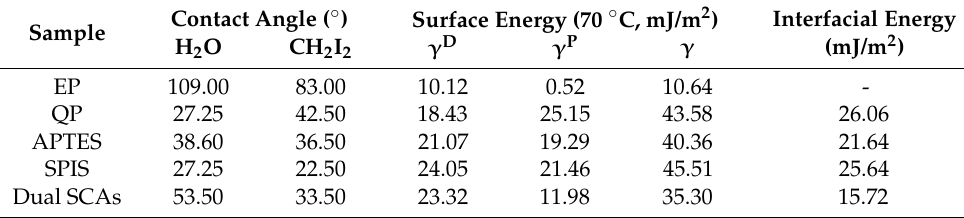
Table 2. Measured contact angle and the calculated surface tension and interfacial tension.